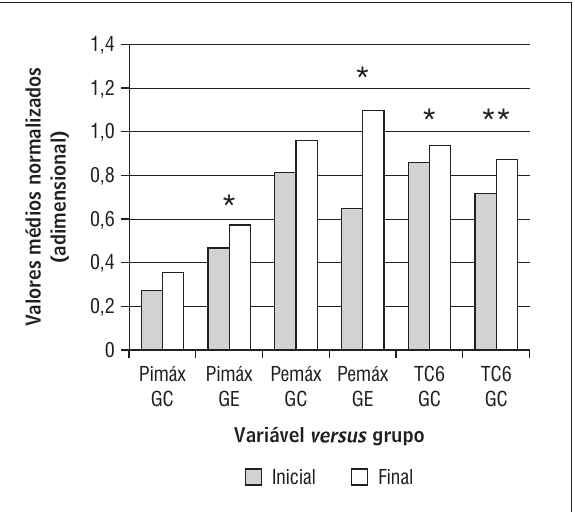
Gráfico 1 - Comparações intragrupo entre as variáveis Pimax, Pemax e TC6 Legenda: Pressão inspiratória máxima = Pimáx; pressão expirató- ria máxima = Pemáx; teste de caminhada de seis minu- tos = TC6; grupo controle = GC; grupo experimental = GE. Os asteriscos representam os níveis de signi fi cância encontrados (*p < 0,01; **p < 0,001) Fonte: Dados da pesquisa.